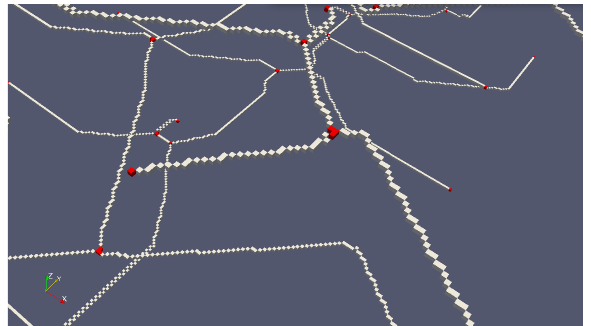
Figure 8. Detection of nodes and edges needed to derive the navigation network from the line skeleton